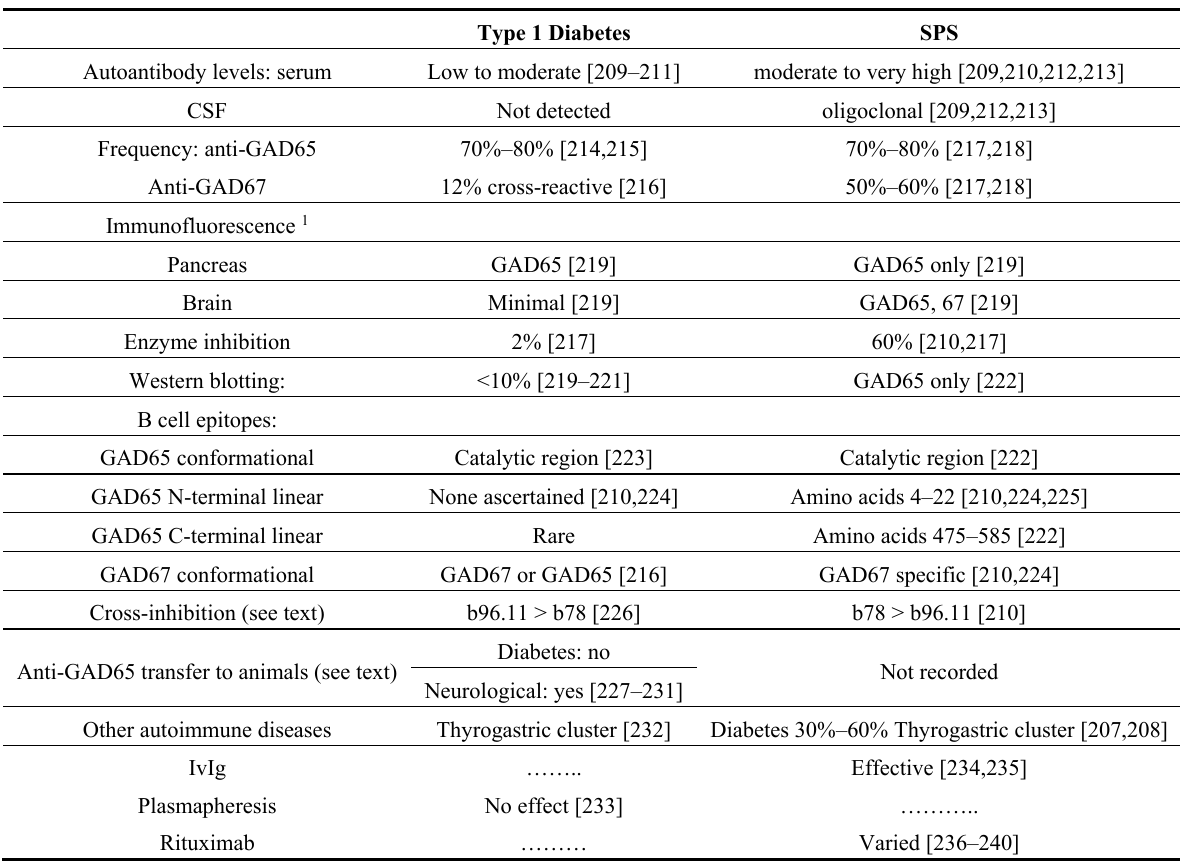
Table 4. Comparison of autoantibodies to glutamic acid decarboxylase (GAD) in type 1 diabetes and